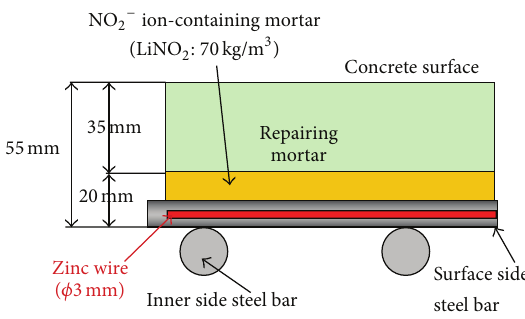
Figure 17: Schematic diagram of the parts repaired.